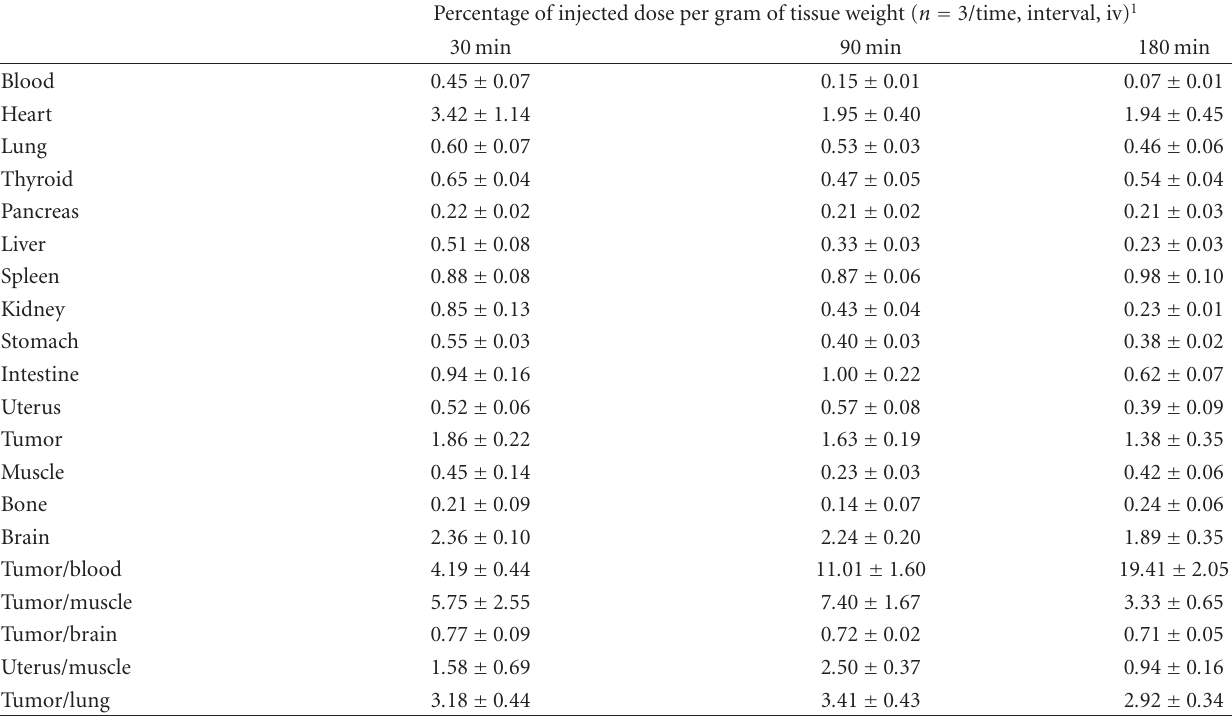
Table 3: Biodistribution of 18 F-FDG in mesothelioma-bearing